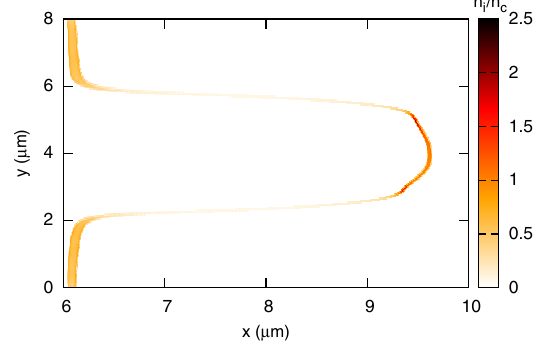
FIG. 8. Density distribution for carbon ions at instant 21 T